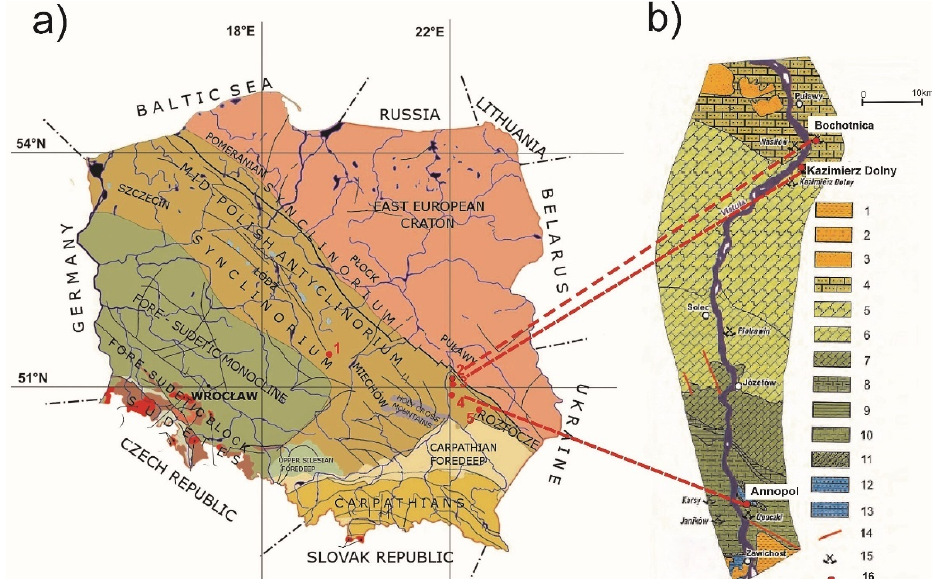
Figure 1. ( a ) Locations of sampling sites against the background of the main tectonic units in area of Poland [47]. Explanations: 1—Be ł chatów; 2—Kazimierz Dolny; 3—Bochotnica; 4—Annopol; 5— Krasnobród; ( b ) Geological outline of the Middle Vistula Valley [42,48]. Explanations: 1—Miocene